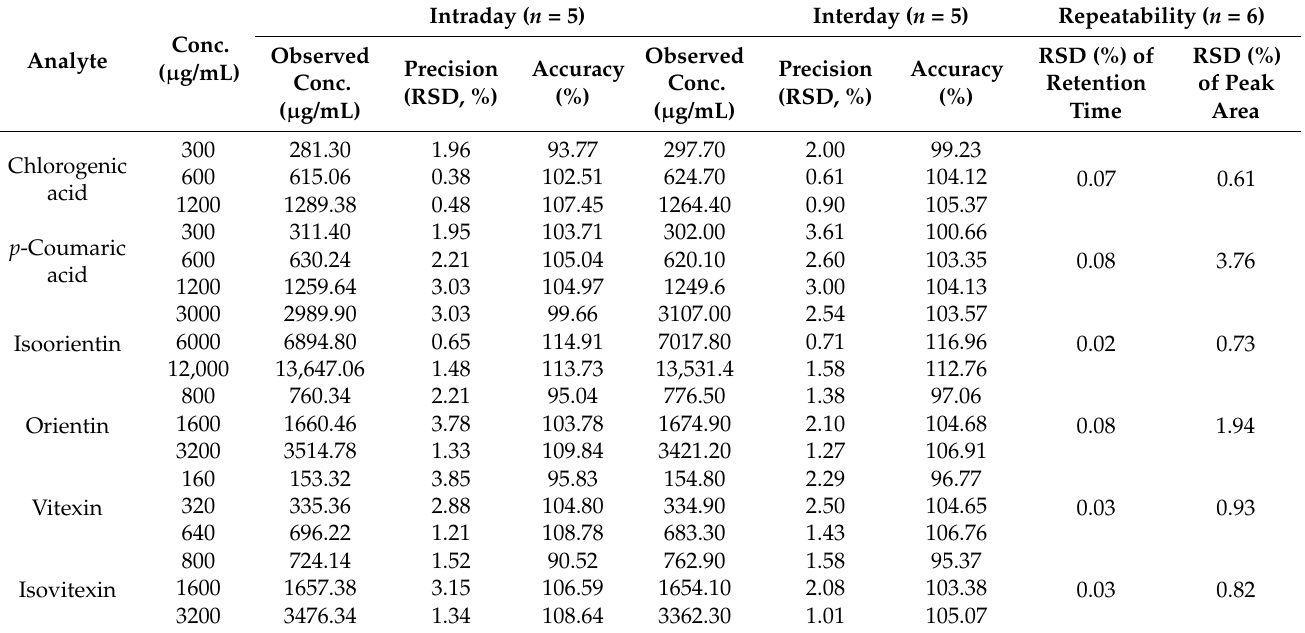
Table 8. Precision data of LC–MS/MS MRM assay for 6 marker components in P. pubescens leaves.